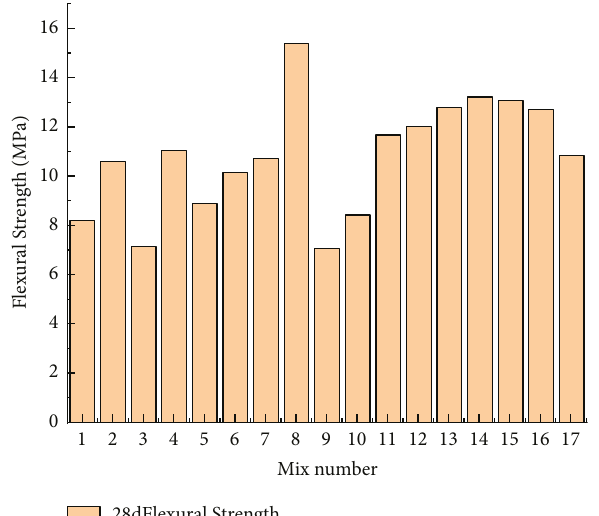
Figure 3: Flexural strength of CBMSPP-ECC with different proportions.